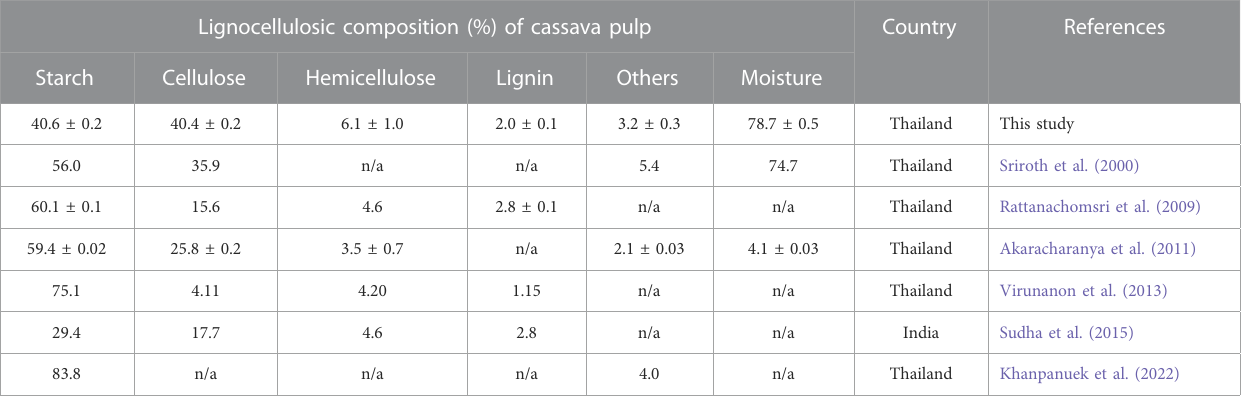
TABLE 1 Lignocellulosic compositions of cassava